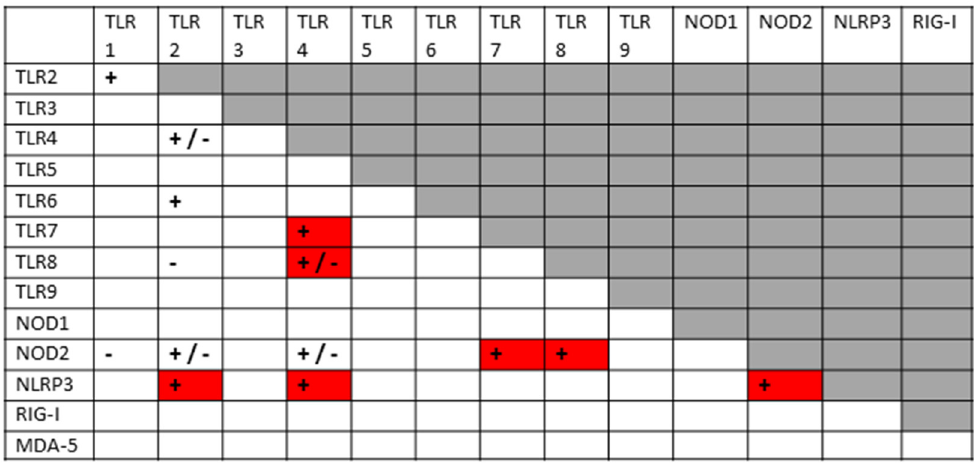
Figure 8. Predicted synergisms (+) and antagonisms ( − ) resulting from anti-phospholipid syndrome activation of innate receptors resulting from mapping Figure 3 (literature review of innate receptor activation) onto the template provided by Figure 2 (summary of known innate receptor synergisms and antagonisms). Red entries indicate extracellular (“bacterial antigen”) receptor synergisms with intracellular and endosomal (“viral antigen”) receptors.